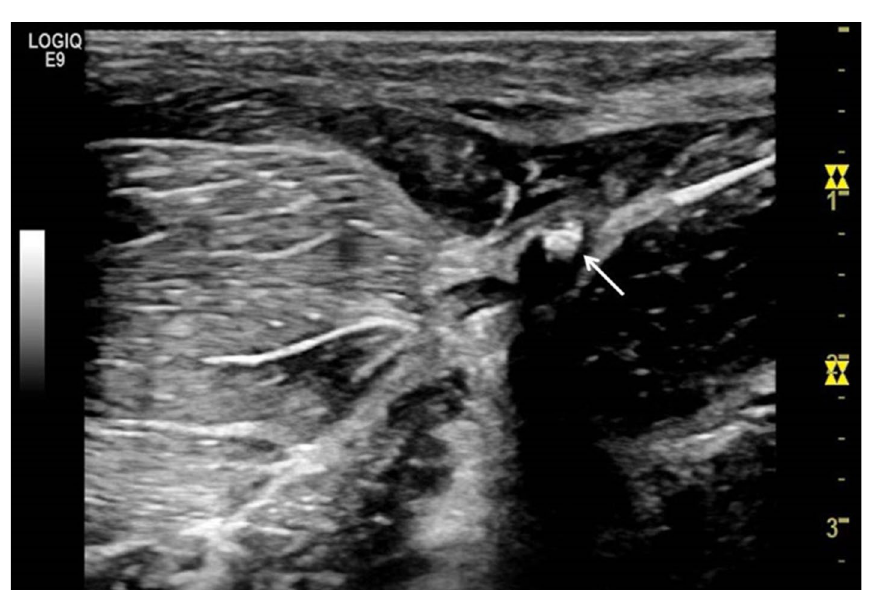
Figure 5. Ultrasonography of the femoral artery confirms ANGIO-SEAL ® VIP Vascular Closure Device